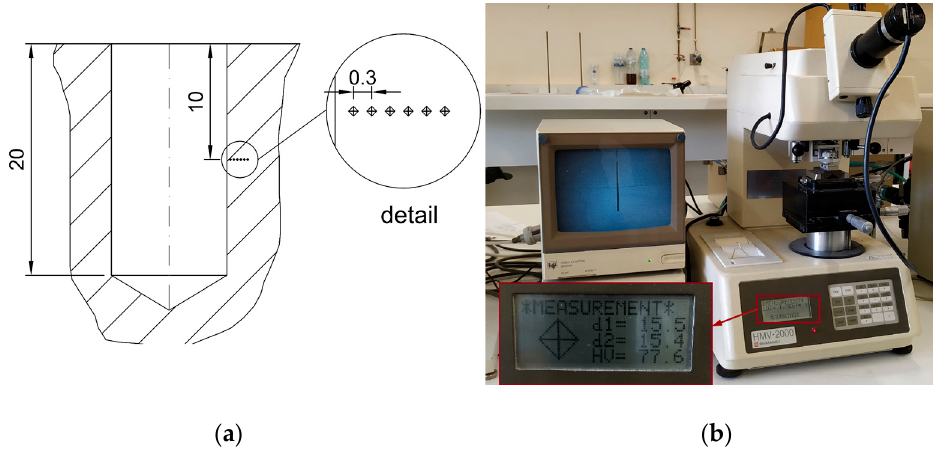
Figure 5. ( a ) Location of indentations in Vickers microhardness tests. ( b ) Microhardness tester Shimadzu HMV-2000.